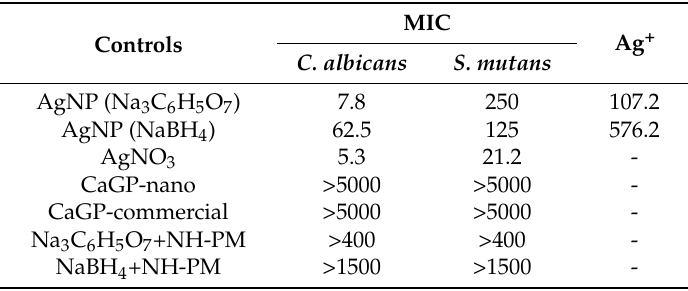
Table 2. Values of minimum inhibitory concentrations (MIC) ( µ g/mL) and silver ions (Ag + ) ( µ g Ag + /mL) of the control solutions: AgNP reduced by sodium citrate (Na 3 C 6 H 5 O 7 ), and by sodium borohydride (NaBH 4 ); silver nitrate (AgNO 3 ); nanoparticulated CaGP (CaGP-nano), and